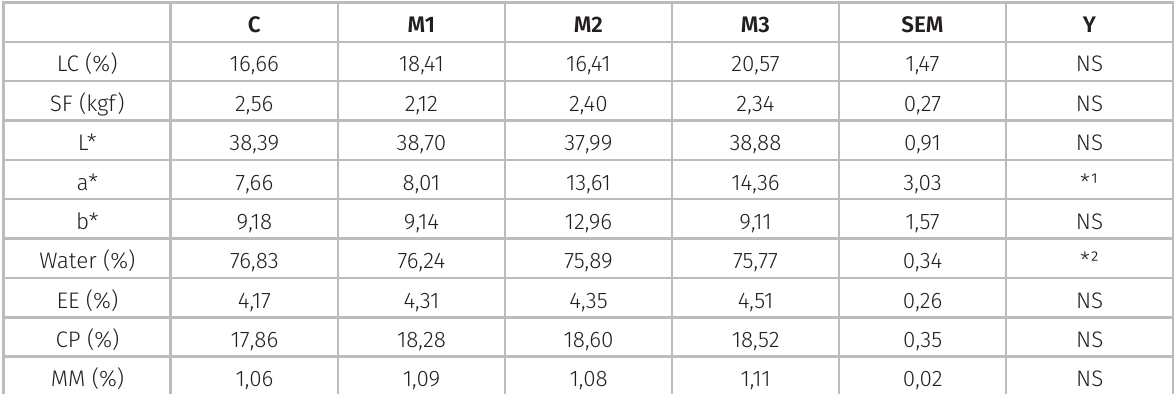
Table V. Physical and chemical characteristics of meat from lambs fed with macadamia by-product.